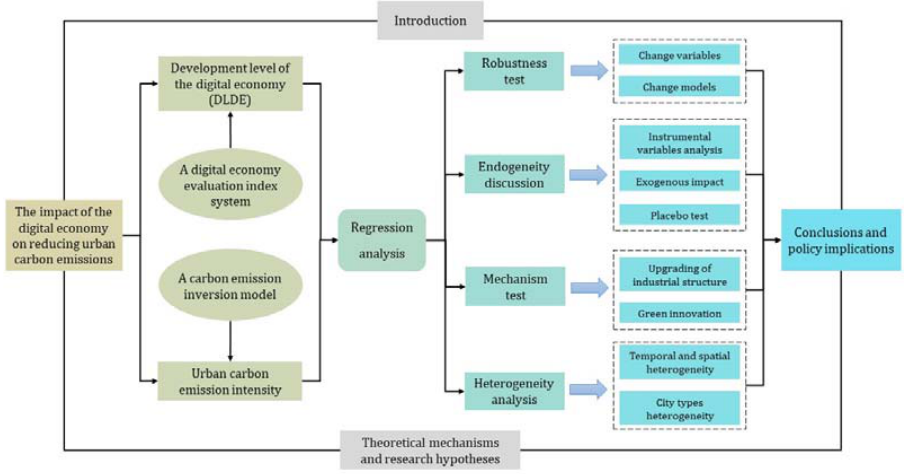
Figure 1. Research Figure 1. Research framework.